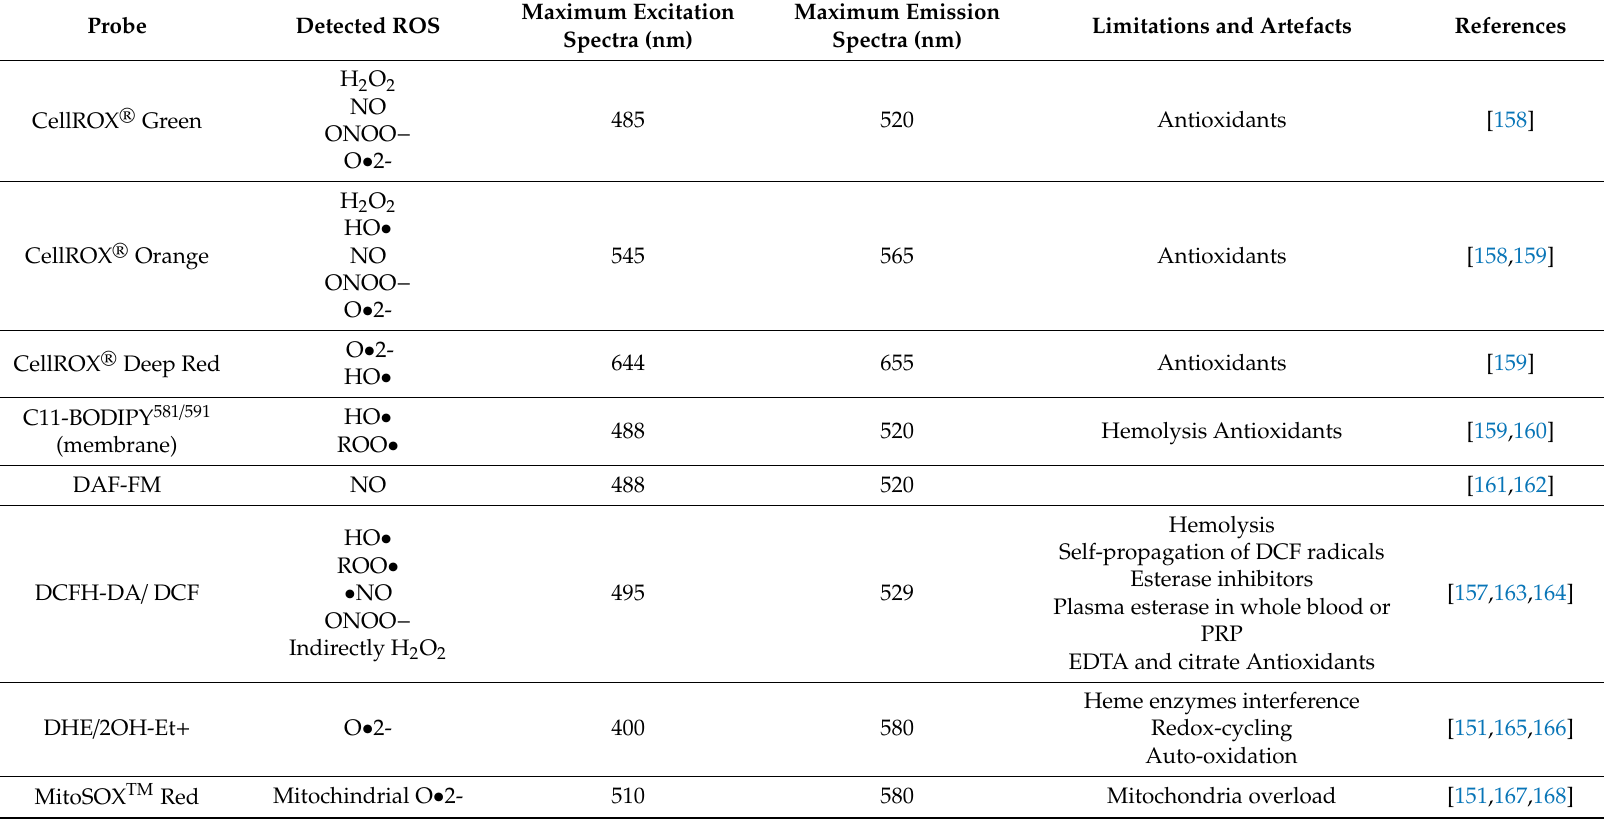
Table 1. Fluorescent probes to detect ROS levels in